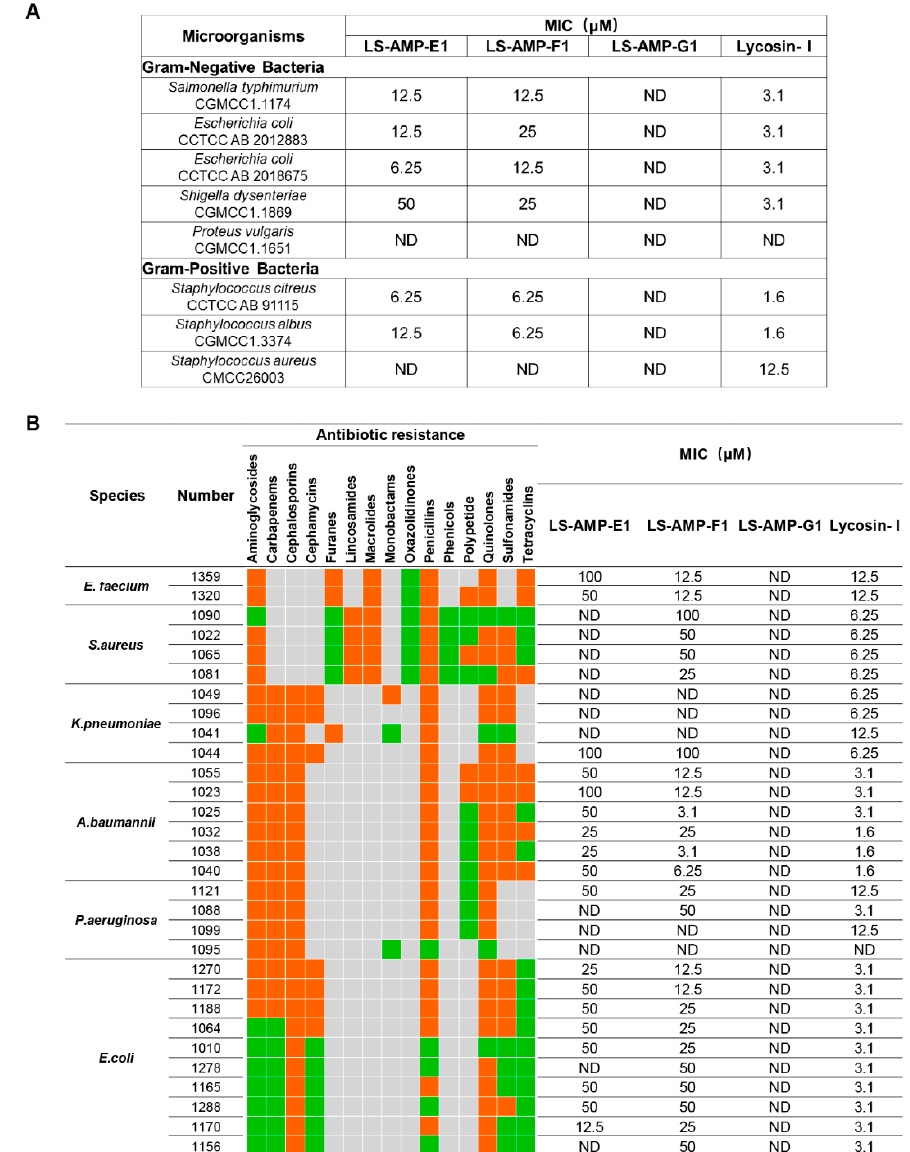
Figure 2. The comparison of antimicrobial activity of LS-AMPs. The MIC values of peptides against standard strains ( A ) and clinical bacterial strains ( B ). Bacteria were susceptible to all (green boxes) or intermediate/resistant to at least one (orange boxes) of the antibiotics per class. Gray boxes are shown if the susceptibility to agents in that class is not assessed. MIC was defined as the minimum concentration to kill the bacterial strains completely. ND: no antimicrobial activity at the concentrations tested.